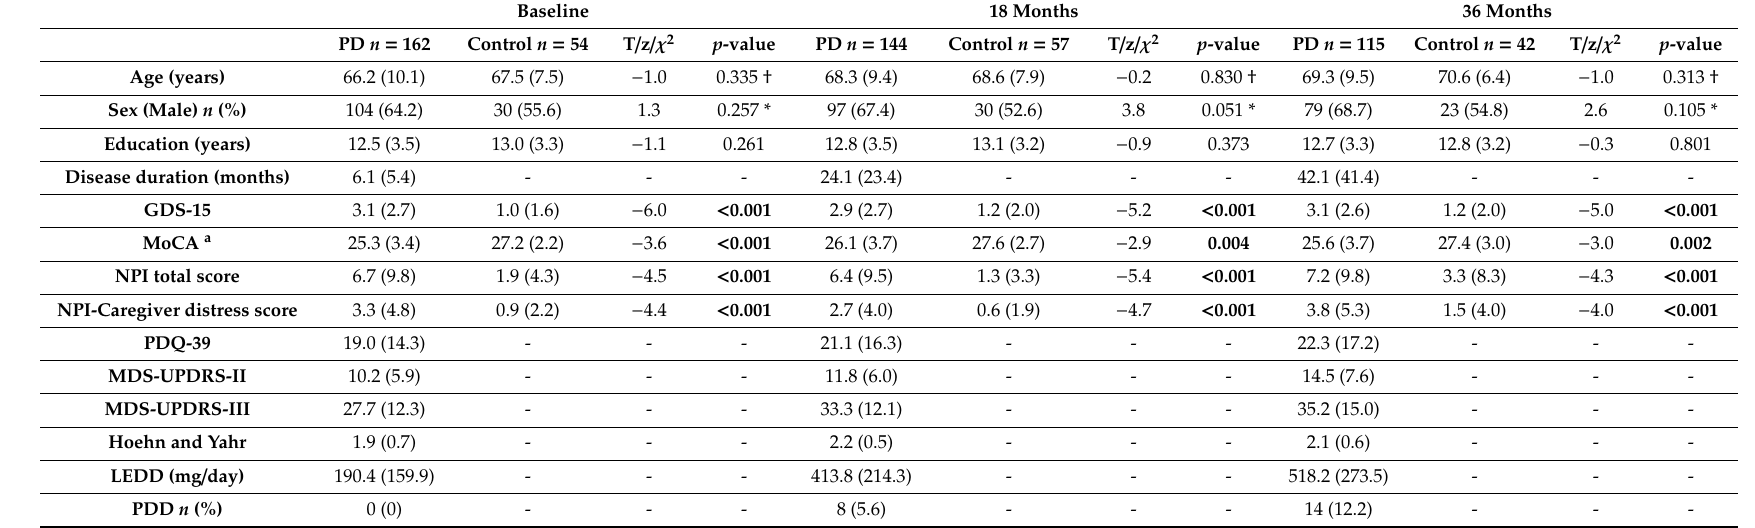
All data presented are means (standard deviations) except where indicated. All data are non-parametric and test statistics are z -scores using Mann–Whitney U -test except where indicated. † = independent t -test, * = chi-squared. Significant values indicated in bold. Abbreviations: GDS-15 = Geriatric Depression Scale-15, MoCA = Montreal Cognitive Assessment, NPI-D